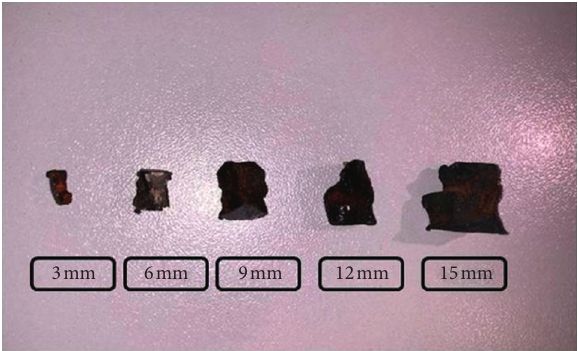
Figure 1: Shrapnel (dimensions of each long axis are shown). Table 1: Shrapnel characteristics.